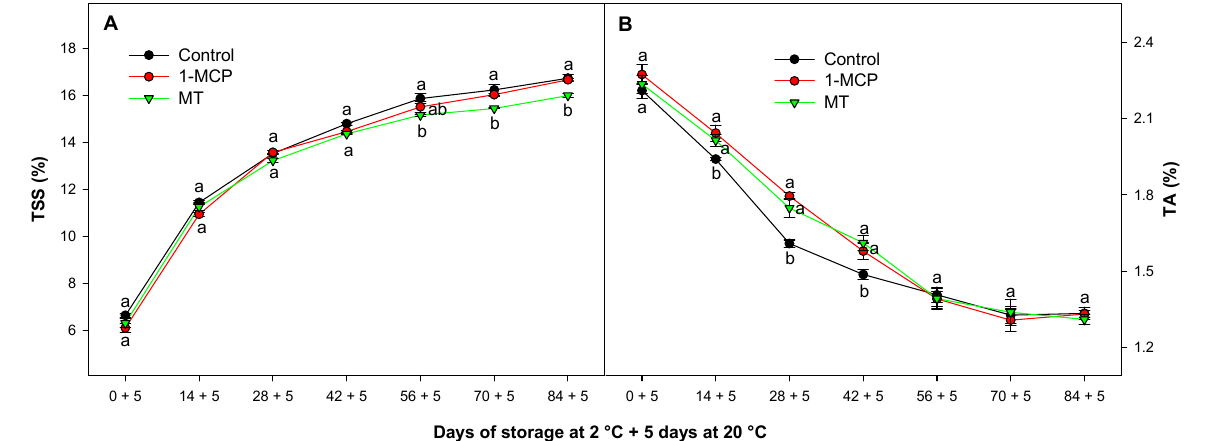
Figure 3. Evolution of total soluble solids (TSSs) ( % ) ( A ) and titratable acidity (TA) ( % ) ( B ) of ‘Hayward’ kiwifruit treated with distilled water (Control), 1-MCP at 0.5 µL L − 1 , or melatonin at 0.1 mM (MT) during cold storage plus 5 days at 20 °C. Data are the mean ± SE ( n = 3). Different lowercase letters show significant differences ( p < 0.05) among treatments for each sampling date.